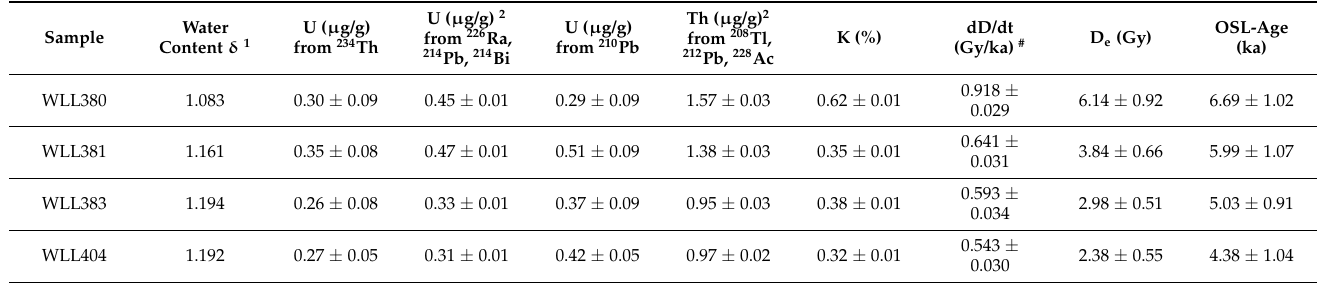
Table 1. Radionuclide, water contents, measured dose rate, equivalent dose, and luminescence ages. Sample